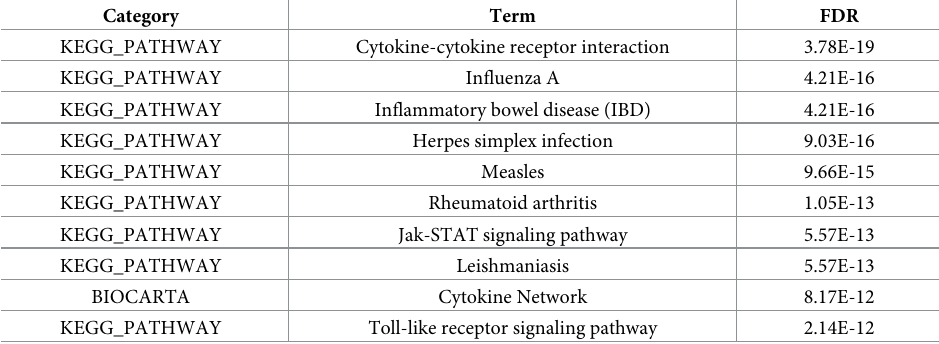
Table 2. The top 10 significant pathways of gene set analysis using associated genes. Category